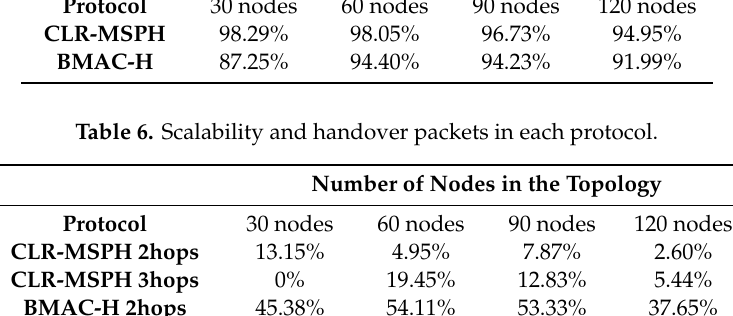
Table 7. The latency of delivered packets in each